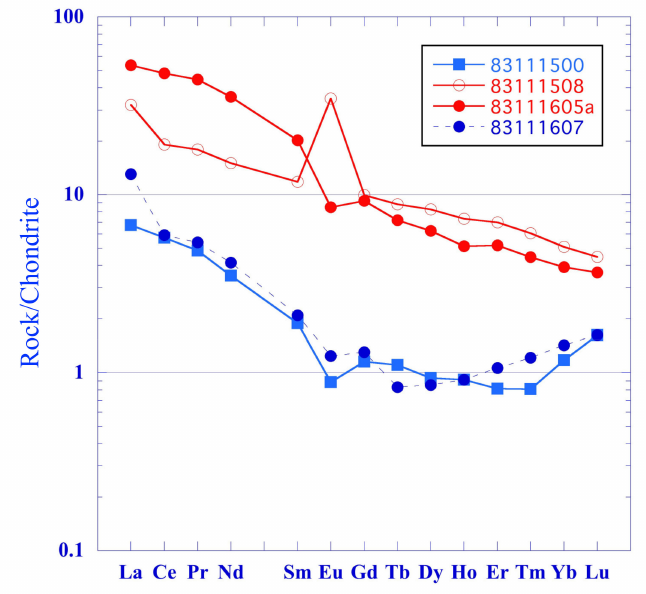
Figure 6. Chondrite-normalized REE patterns for the Kamioka ores and a crystalline limestone (Table 2). The REE concentrations in CI chondrite are taken from [29]. Note that the REE pattern